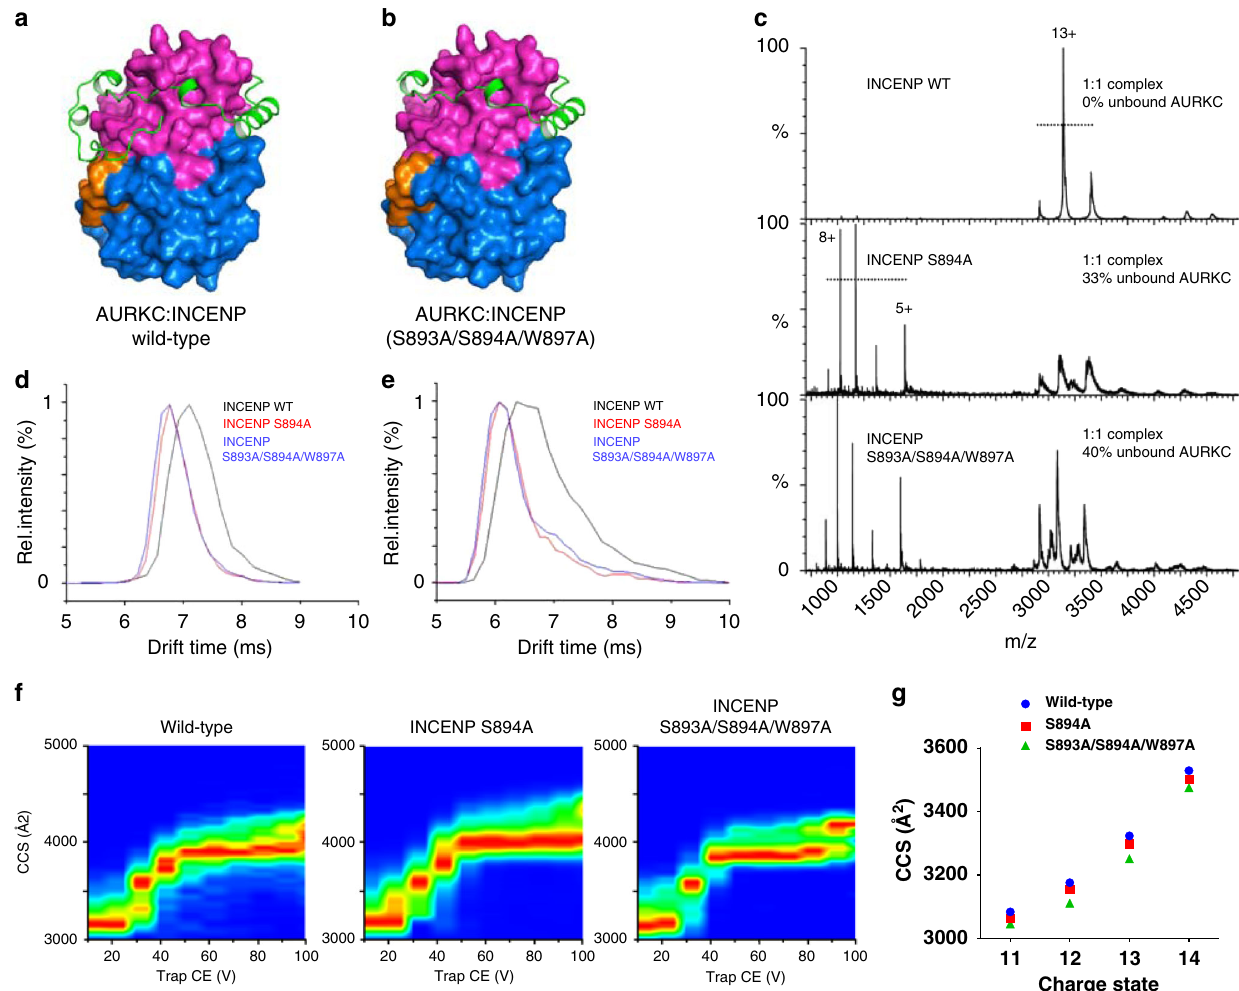
Fig. 3 TSS motif binding affects AURKC:INCENP binding and shape. a , b Models of the effect of loss of TSS motif binding from a phosphorylated and ordered INCENP TSS motif as seen in the crystal structure ( a ) to an unphosphorylated TSS motif and disordered C-terminal part of INCENP ( b ). c Native mass spectra of AURKC:INCENP complexes show that under the same gentle ionisation conditions the wild-type AURKC:INCENP complex remains intact while the non-phosphorylated INCENP mutants are only partially bound. This is shown by the single peak series around m / z 3000 – 3200 for the wild-type AURKC:INCENP complex (MW expected 40501 Da, observed 40747 Da; one AURKC phosphorylation and two INCENP phosphorylations), while there are separate charge state series for the individual AURKC and INCENP proteins when samples of INCENP mutant complexes were measured (AURKC: INCENP-S894A MW expected 40059 Da, observed 40224Da; one AURKC phosphorylation and one INCENP phosphorylation, and AURKC:INCENP- S893A/S894A/W897A MW expected 39928 Da, observed 40009 Da; one AURKC phosphorylation). d , e Without a phosphorylated INCENP TSS motif the AURKC:INCENP complexes have shorter ion mobility drift times (12 + and 13 + charge states shown). f Collision-induced unfolding shows the AURKC: INCENP mutant complexes reach the greatest extension already at lower energies consistent with greater structural fl exibility. g The experimental CCS values of the AURKC:INCENP complexes were calculated after calibration from the ion mobility drift times. At all charge states the INCENP mutant complexes have a reduced collision cross-section consistent with a reduced size of the compact, ordered and folded protein